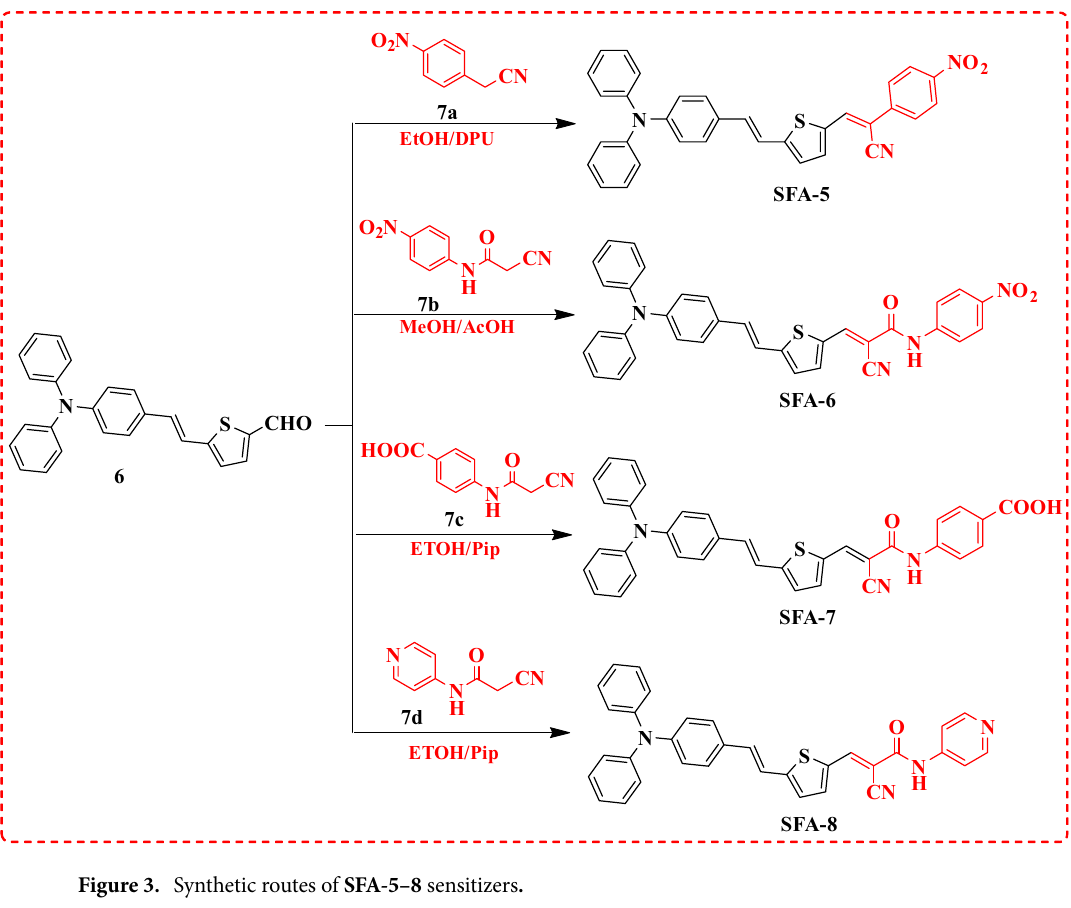
Figure 3. Synthetic routes of SFA-5–8 sensitizers .